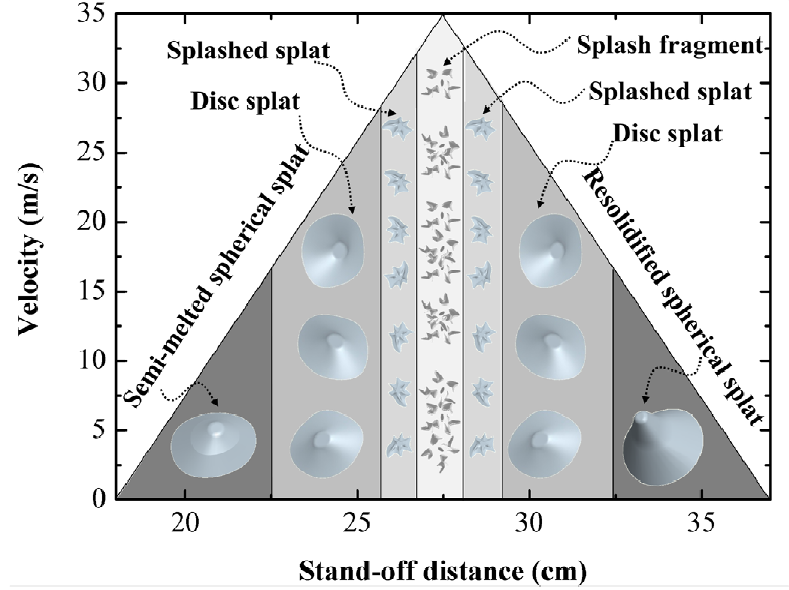
Figure 14. Temperature–Stand-off (TS) map of EMAA single splats.